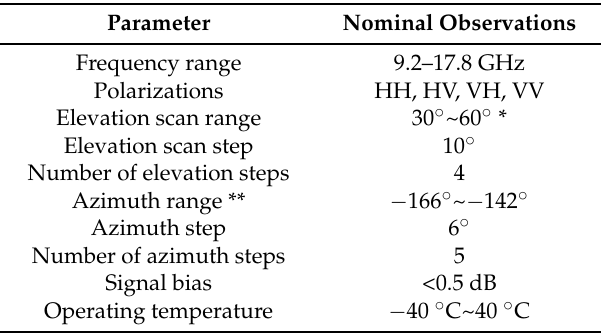
Table 5. SnowScat